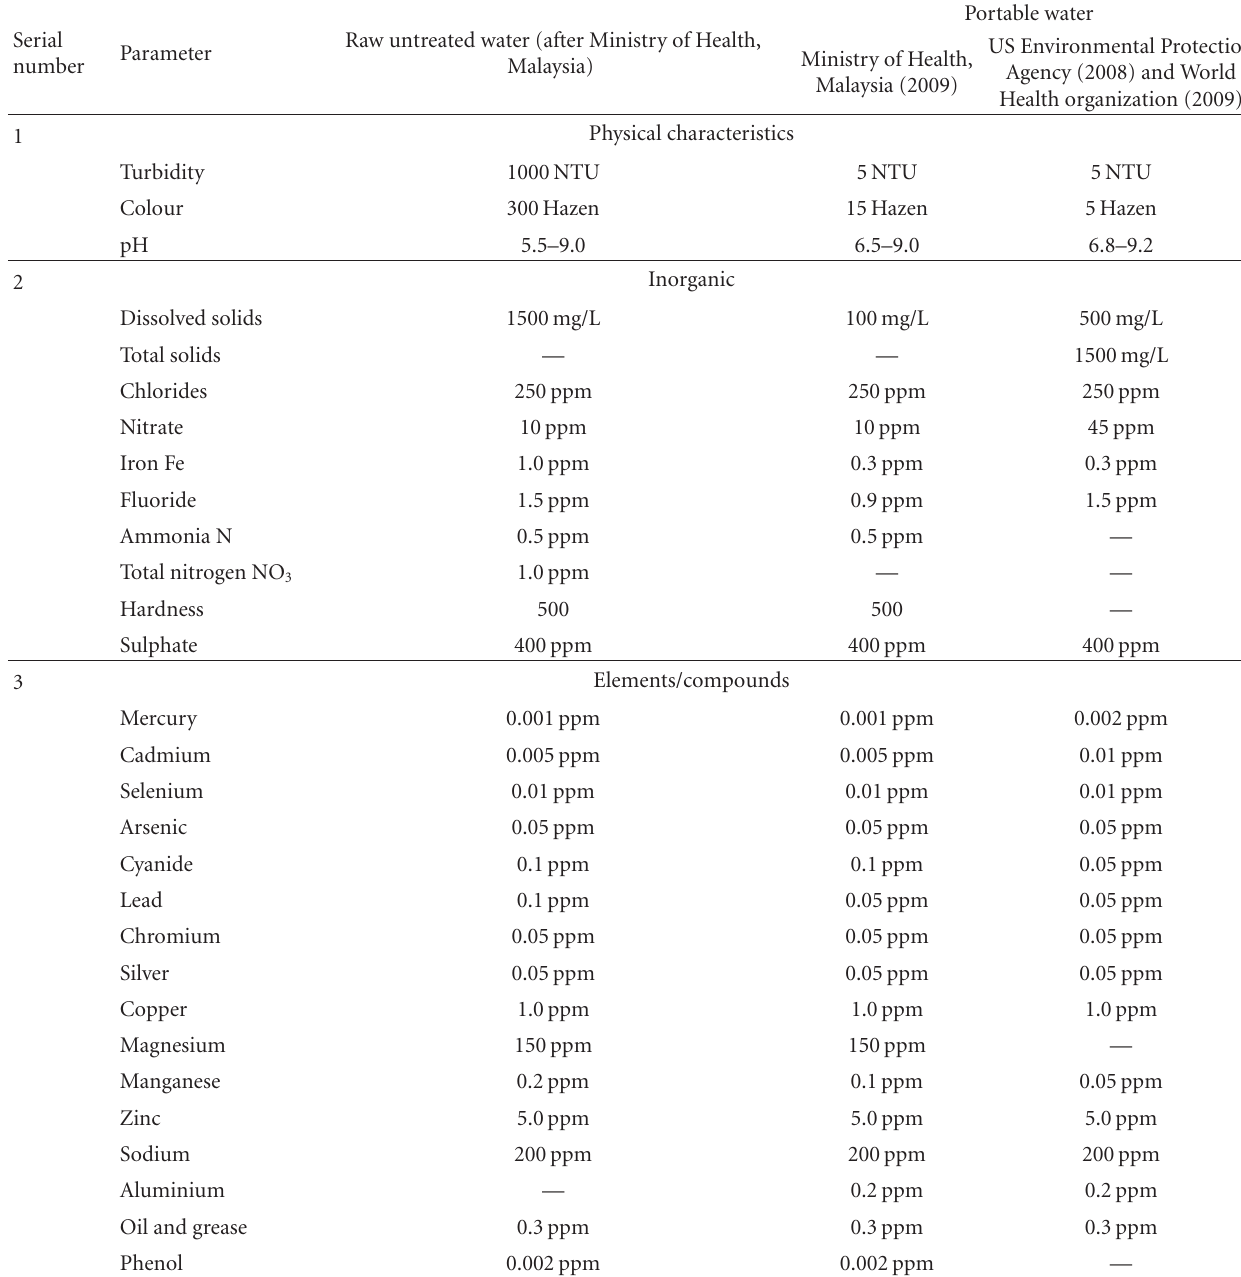
Table 3: Maximum allowable limit for raw water and portable